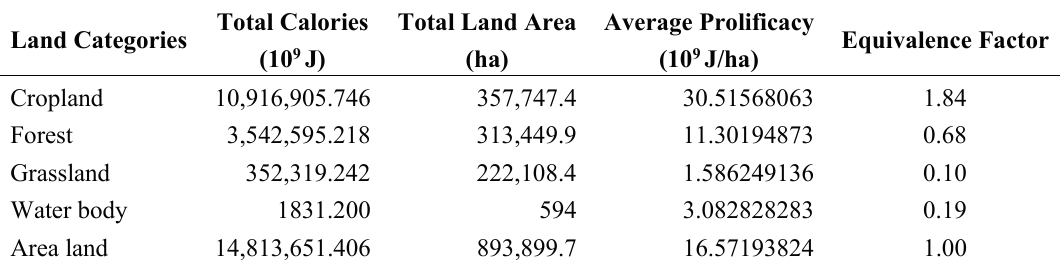
Table A2. Productivity and equivalence factors of land in Guyuan in 2012.